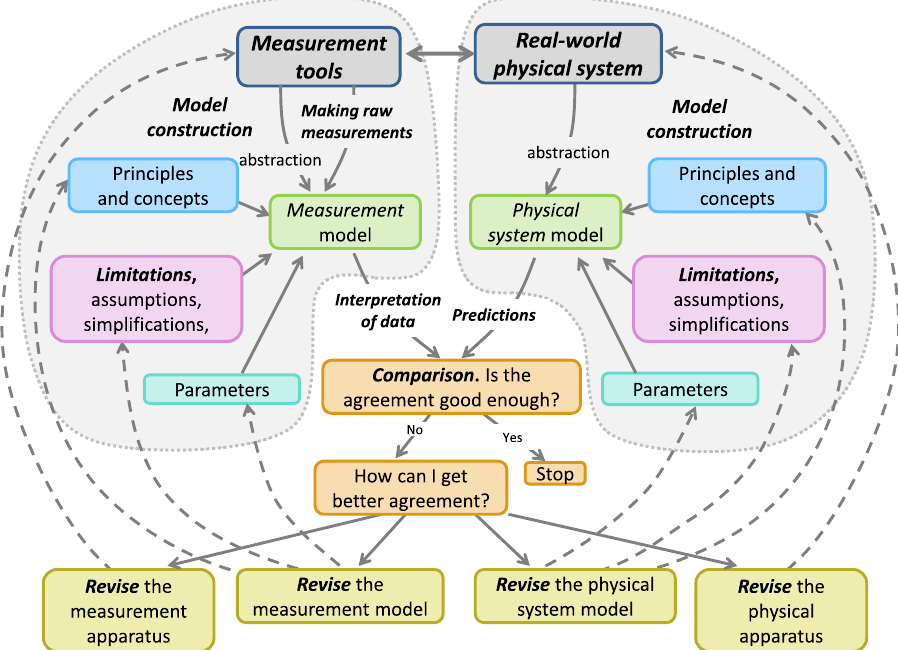
FIG. 2. The modeling framework describes a process that includes constructing models of the measurement tools and physical system, making predictions, making measurements, interpreting measurements using the measurement model, comparison between predictions and measurements, and several pathways for revision of the models and apparatus. The labels in italics correspond to key facets of modeling that are also coded in the think-aloud laboratory activities (see Figs. 5 and 6). The model construction phases shown in the top right and top left align with the key components of models shown in Fig. 1. Color is used in the diagram to highlight the distinct phases of the modeling process and to highlight the symmetry between the modeling process for the measurement tools and physical